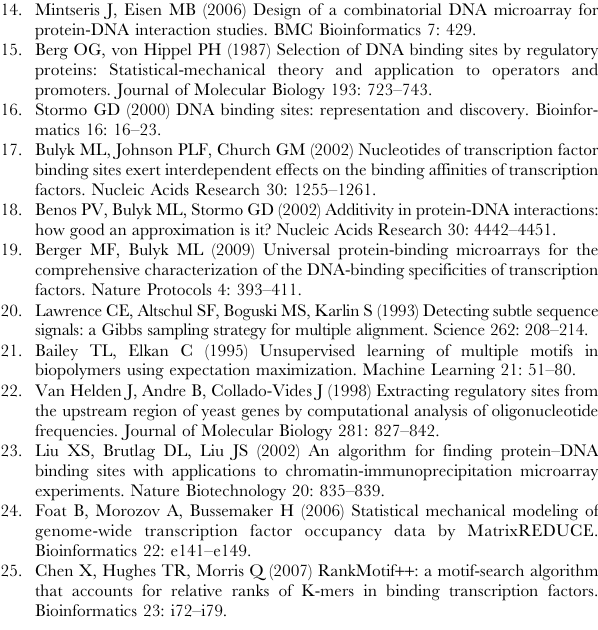
prediction models. Included among the 7 models are the highest median intensity K-mer (HMIK) predictor, and 6 versions of the linear prediction model with different preprocessing steps. Table S2 Prediction accuracies for all 86 sample pairs (ME R HK). Legend: This table contains the full prediction accuracy assessments for all 86 PBM sample pairs and 7 different prediction models. Included among the 7 models are the highest median intensity K-mer (HMIK) predictor, and 6 versions of the linear prediction model with different preprocessing steps. Table S3 Top 20 highest affinity K-mers for all 86 HK array samples. Legend: This table lists the top 20 highest affinity K-mers for each of the 86 HK array samples. The K-mers were learned using the linear model with low intensity probe filtering, spatial detrending and quantile normalization enabled. Table S4 Top 20 highest median intensity K-mers for all 86 HK array samples. Legend: This table lists the top 20 highest median intensity K-mers for each of the 86 HK array samples. By the median intensity of a K-mer we mean the median intensity across all probes that contained the K-mer. This table is provided for the purposes of comparing with Table S3. Table S5 Comparison between strand specific and non-specific models. Legend: This table lists the prediction accuracies for both the strand specific and non-specific models, for all 86 paired PBM samples. The predictions were made in the HK R ME